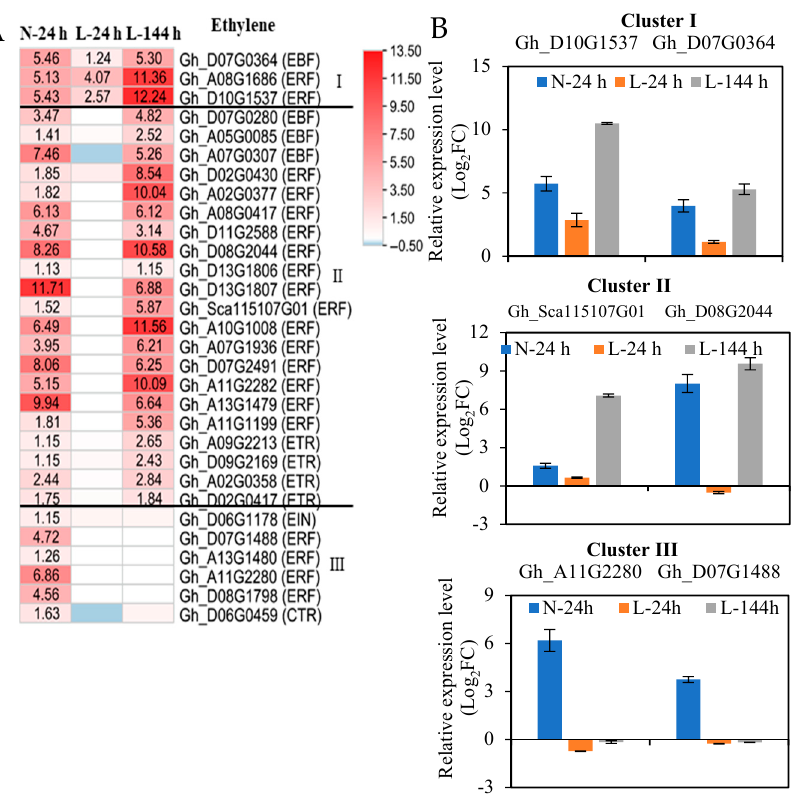
Figure 4. The expression of ethylene-signaling genes in AZs treated with TDZ at different temper- atures. ( A ) Heatmap generated based on the RNA-seq data. The number in the box indicates the fold-change expression of the gene (only those with a ≥ one-fold difference are shown). TDZ-induced downregulated and upregulated expressions are indicated by blue and red colors, respectively. I, II, and III represent three types, respectively. All the numbers in the heatmap represent fold changes; ( B ) the expression levels of selected genes from RT-qPCR.